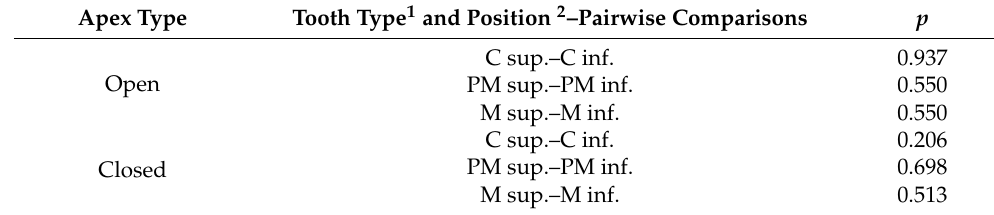
Table 5. Pairwise comparisons between superior and inferior permanent teeth by tooth type.